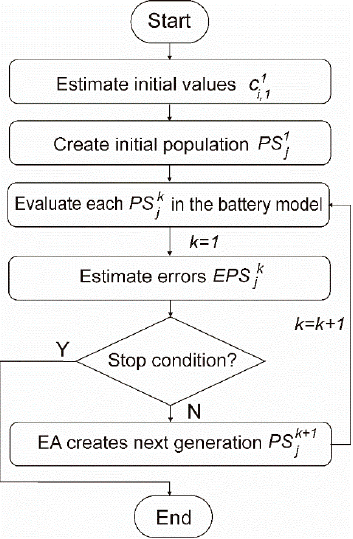
Figure 4. Global identification process algorithm.